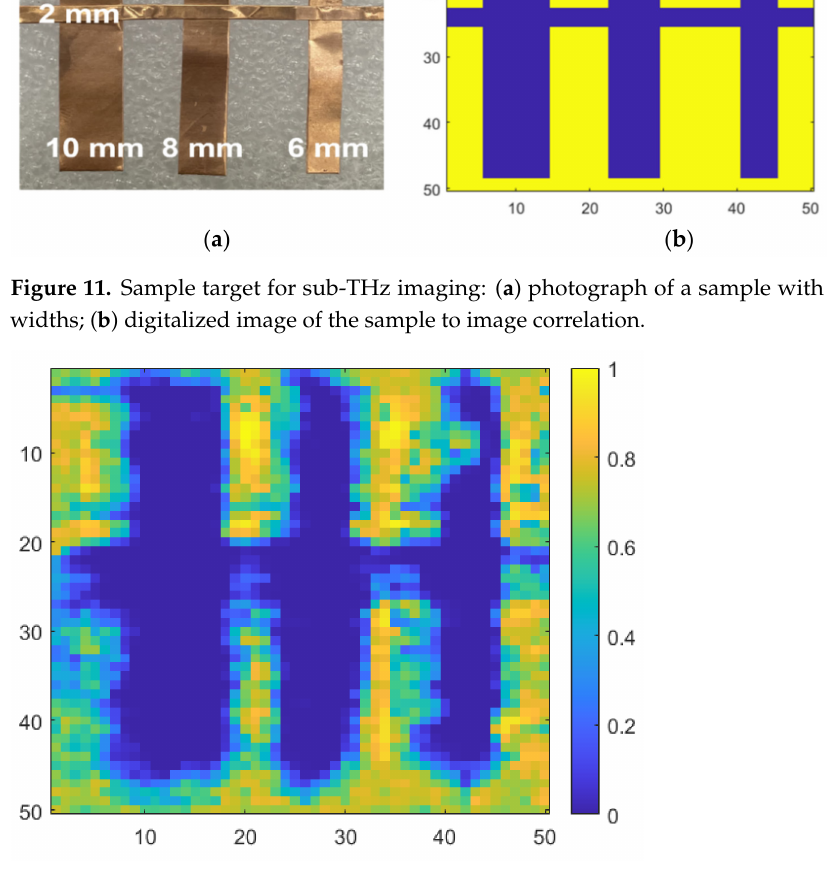
Figure 12. Measurement image using the proposed CMOS detector